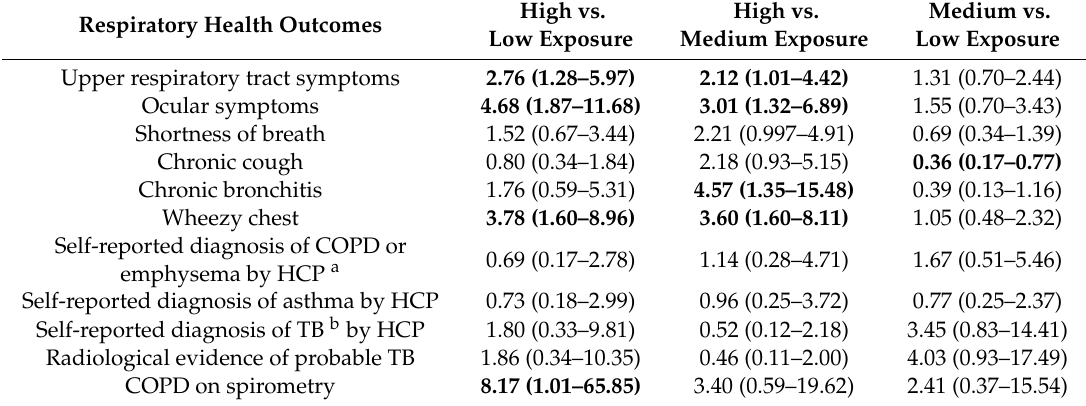
Table 4. Multivariate logistic regression models of the associations between exposure group and respiratory health outcomes with adjusted odds ratios and 95% confidence